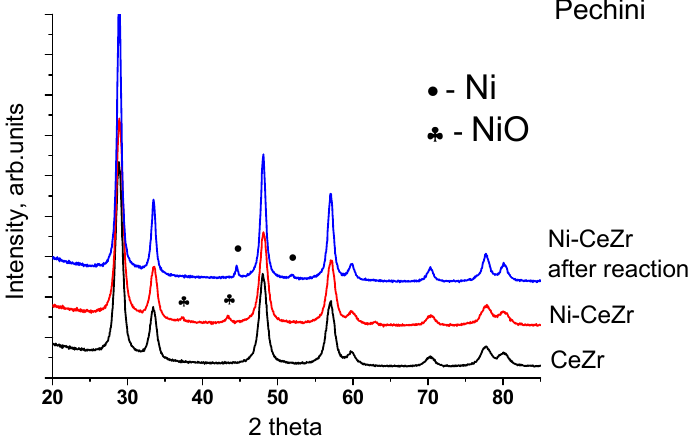
Figure 5. Diffraction patterns of Ni-containing catalyst based on CeZr mixed oxide prepared by Pechini method before and after reaction.